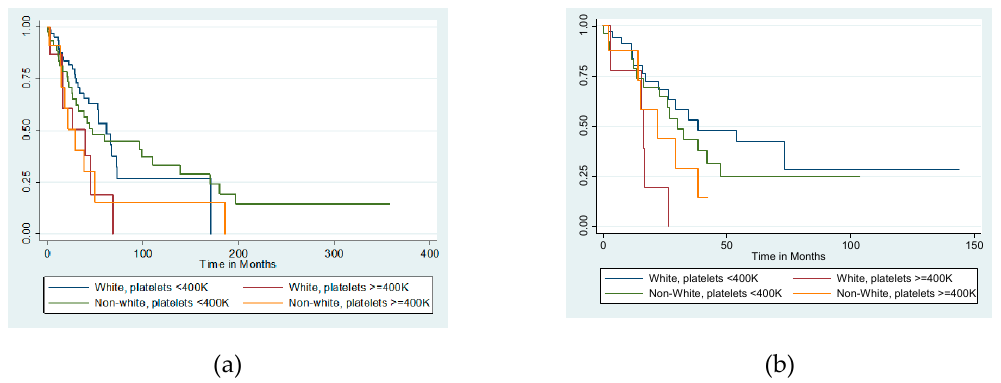
Figure 3. Overall survival by thrombocytosis and race in ( a ) the entire high-grade endometrial cohort (log-rank p = 0.008) and ( b ) serous carcinomas only ( p = 0.01).